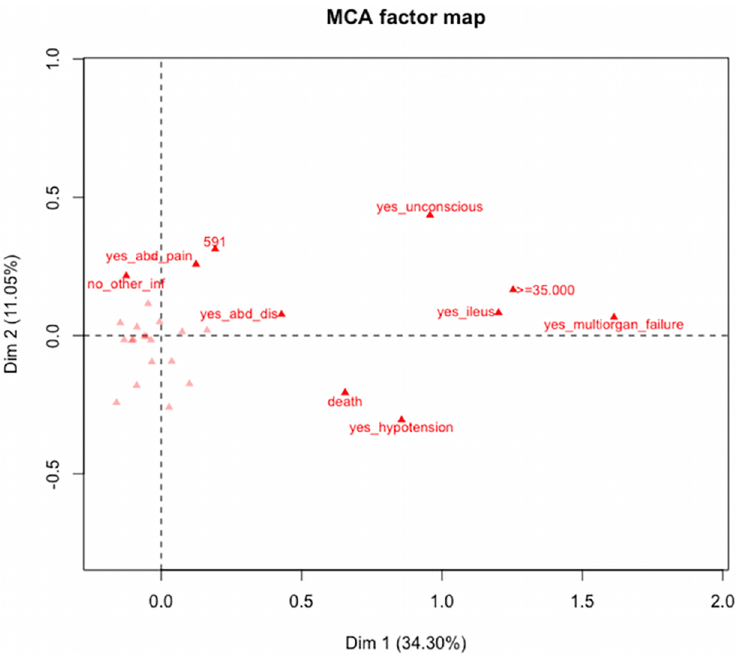
Fig 1. Multiple correspondence analyses. Variable categories contributing to dimension 1 (x-axis) and dimension 2 (y axis); variables with major contribution are close to the cero line in the chart. Ten variables contributing to both dimensions are